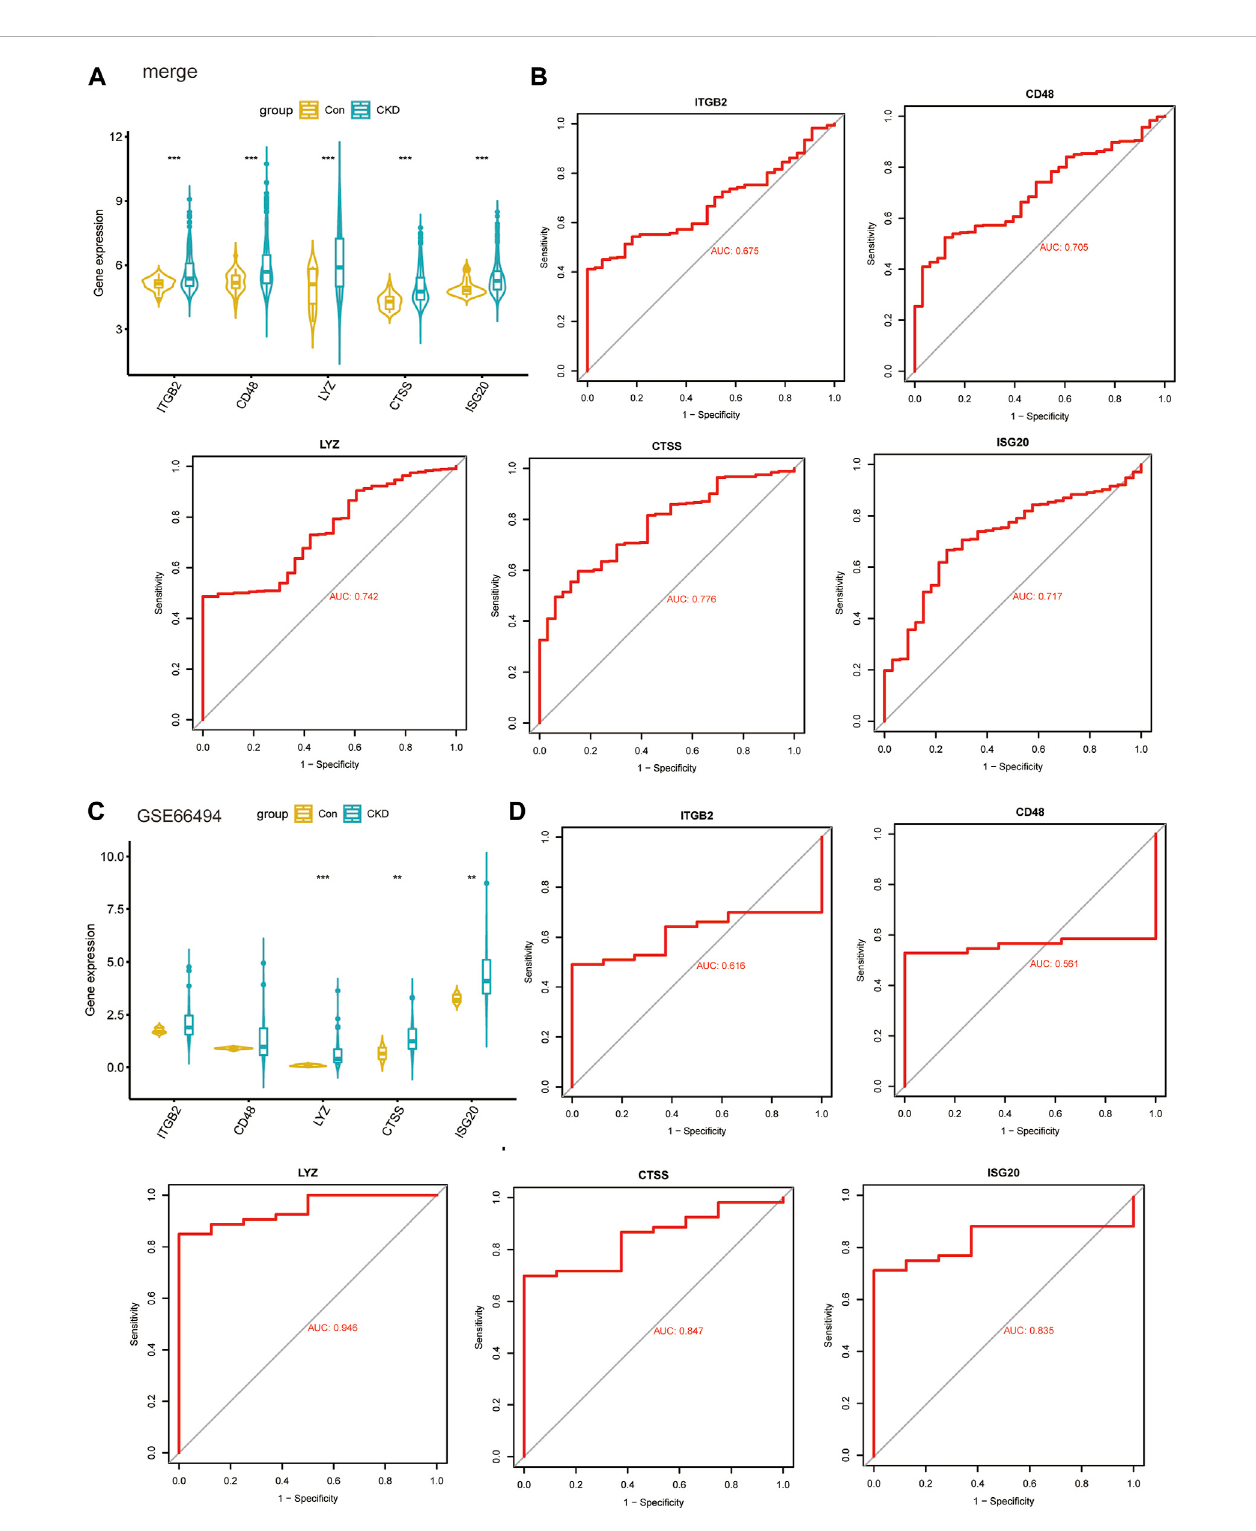
FIGURE 9 Validate clinical diagnostic capabilities of key biomarkers. (A, B) Expression levels (A) and diagnostic potency (B) of key genes in the models in the four combined datasets. (C, D) Expression levels (C) and diagnostic potency (D) of key genes in the models in the dataset GSE66494.